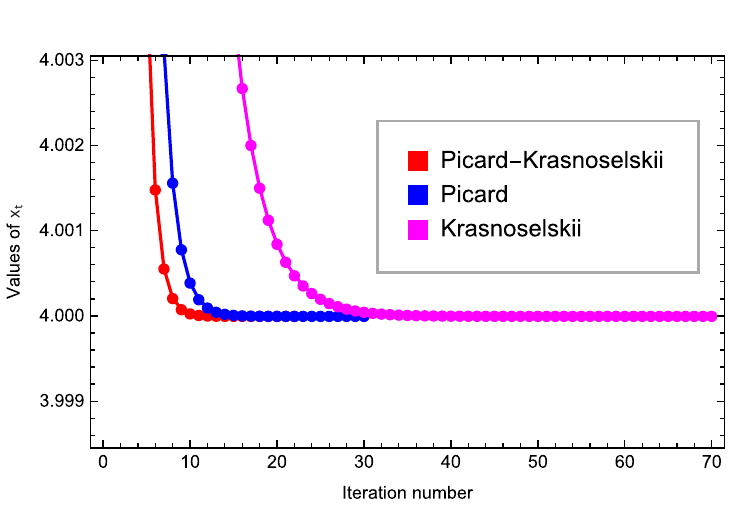
Figure 1: Graphical representation of the values obtained in Table